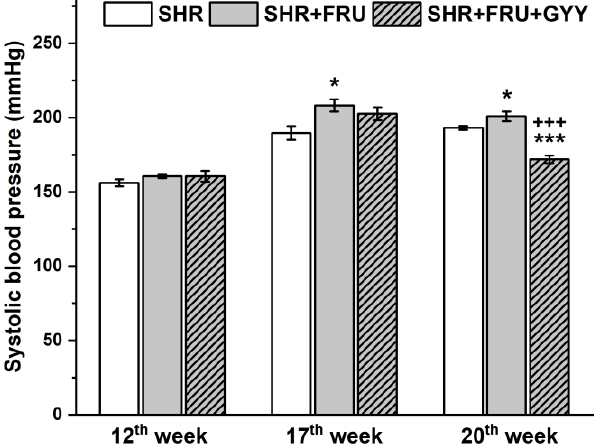
Figure 1. The values of the systolic blood pressure in control SHR (SHR, n = 8), SHRs treated with 10% fructose solution (SHR+FRU, n = 8), and SHRs treated with 10% fructose solution and 266 µg/kg/day GYY-4137 (SHR+FRU+GYY, n = 8). Data are shown as mean SBP ± S.E.M. Statistical analysis was performed by one-way ANOVA with a Bonferroni post-hoc test. * p < 0.05 vs. SHR, *** p < 0.001 vs. SHR, +++ p < 0.001 vs. SHR+FRU.